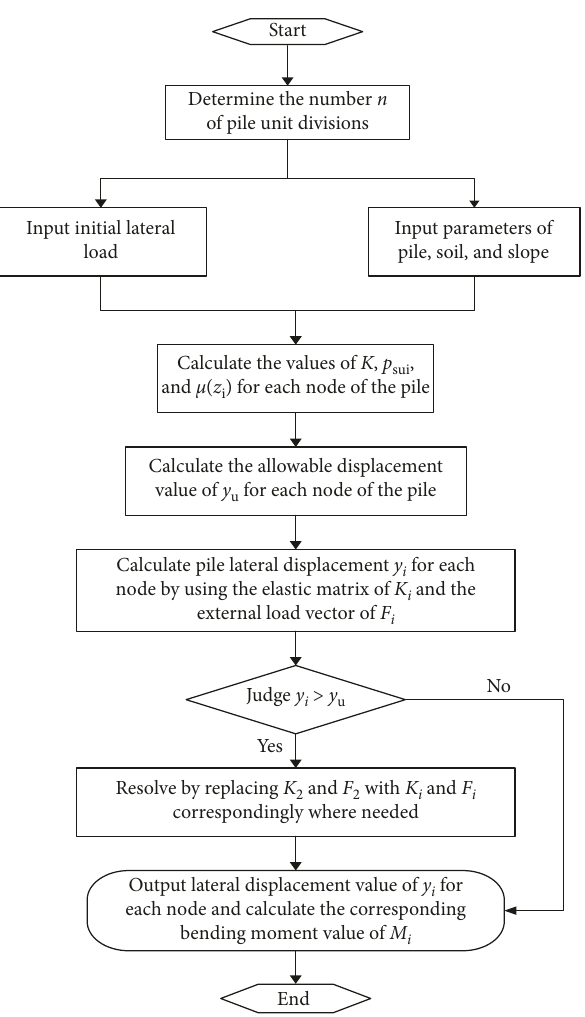
Figure 5: Flowchart of iterative